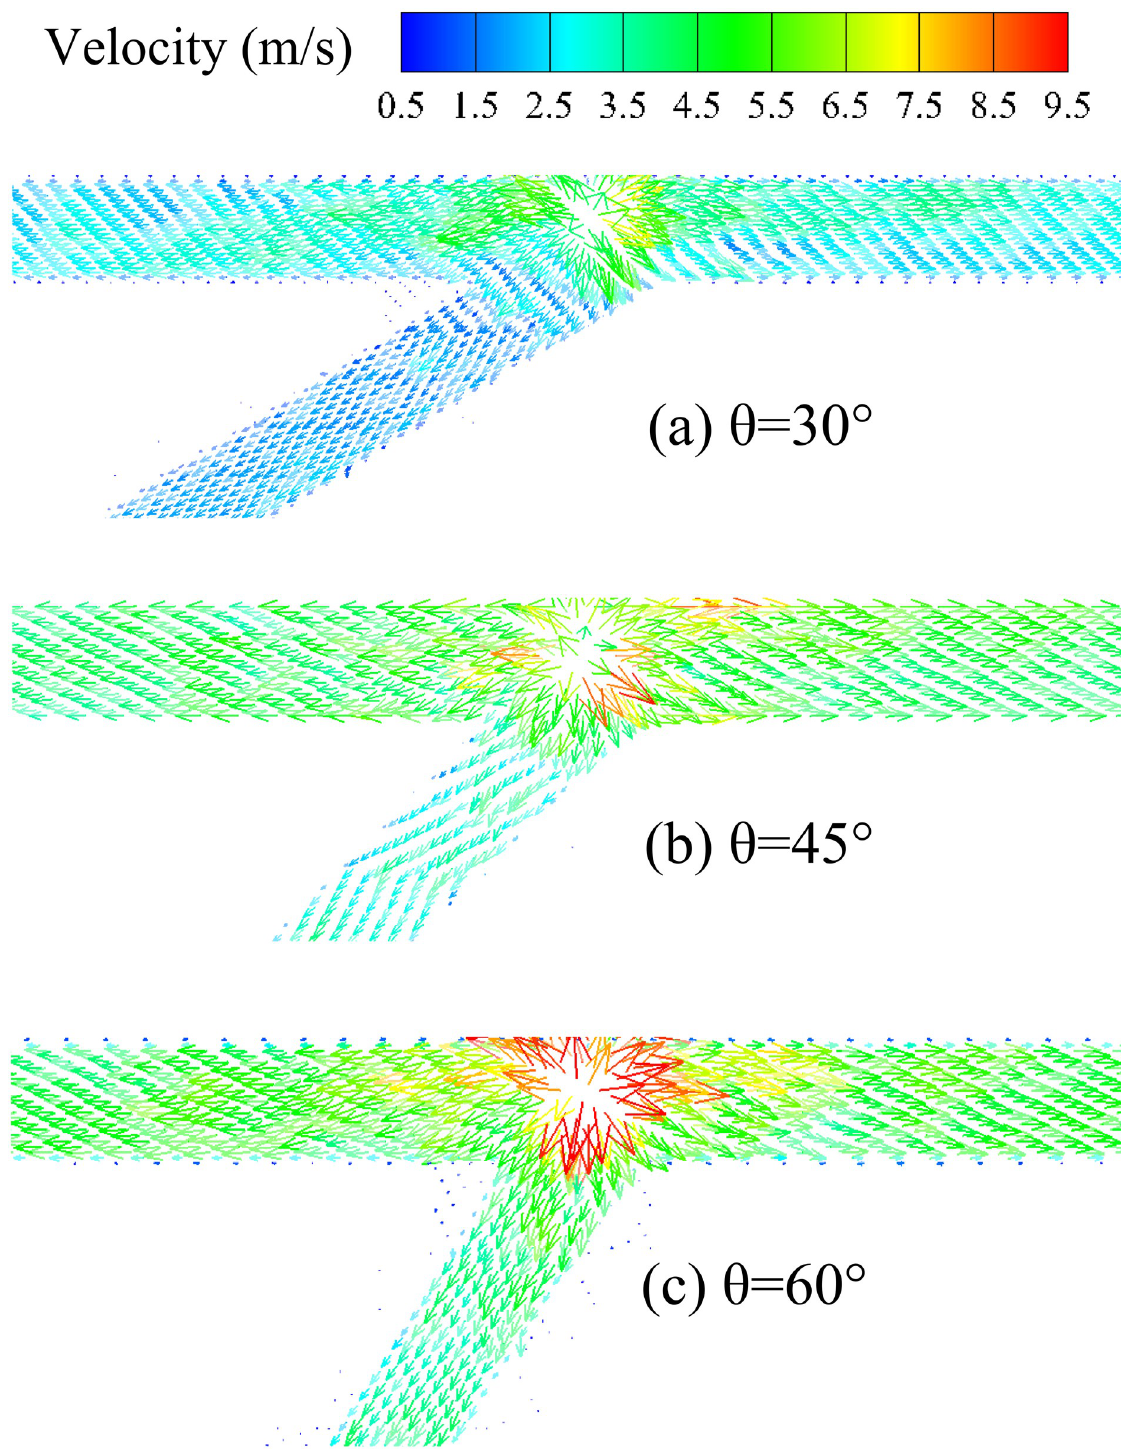
Fig 7. Velocity contours for various bifurcation angles at HRR of 20 MW (top view).